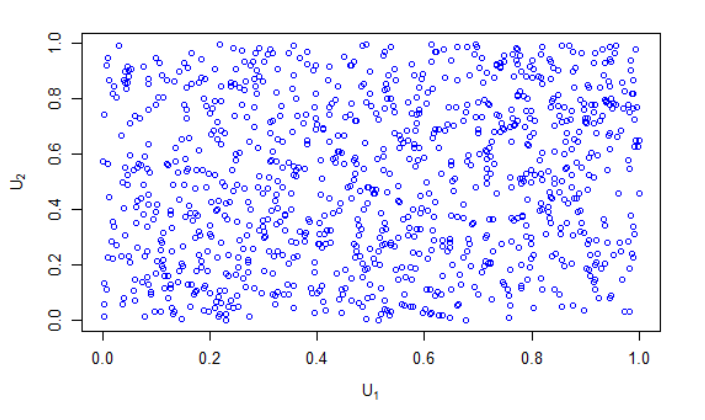
Figure 8. The estimated Gaussian distribution, Tau =